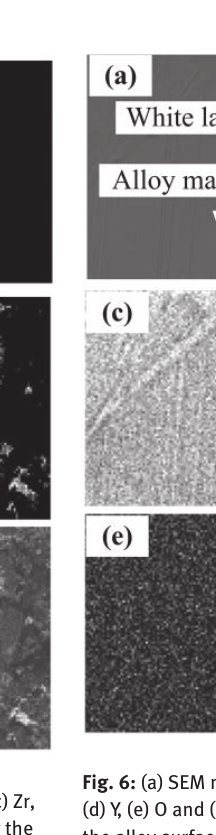
Fig. 5: (a) SEM micrograph, and SEM X-ray dot maps of (b) Ti, (c) Zr, (d) Al, (e) Ca and (f) O of the selected region in fig. 2, revealing the distribution of elements in phases.